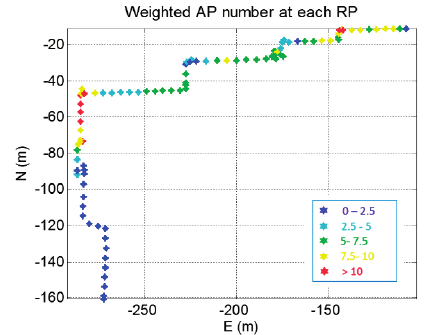
Figure 14. WiFi signal distribution at the Engineering building (ENB).